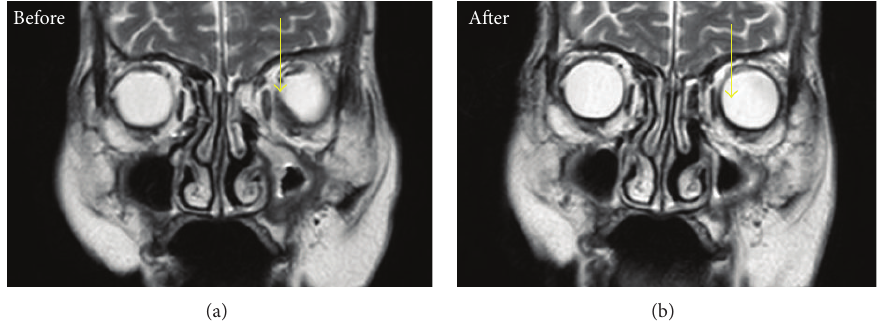
Figure 2: Coronal T2-weighted images showing a left choroidal tumor and space-occupying lesions in left paranasal sinus (arrow) before and 3 weeks after steroid